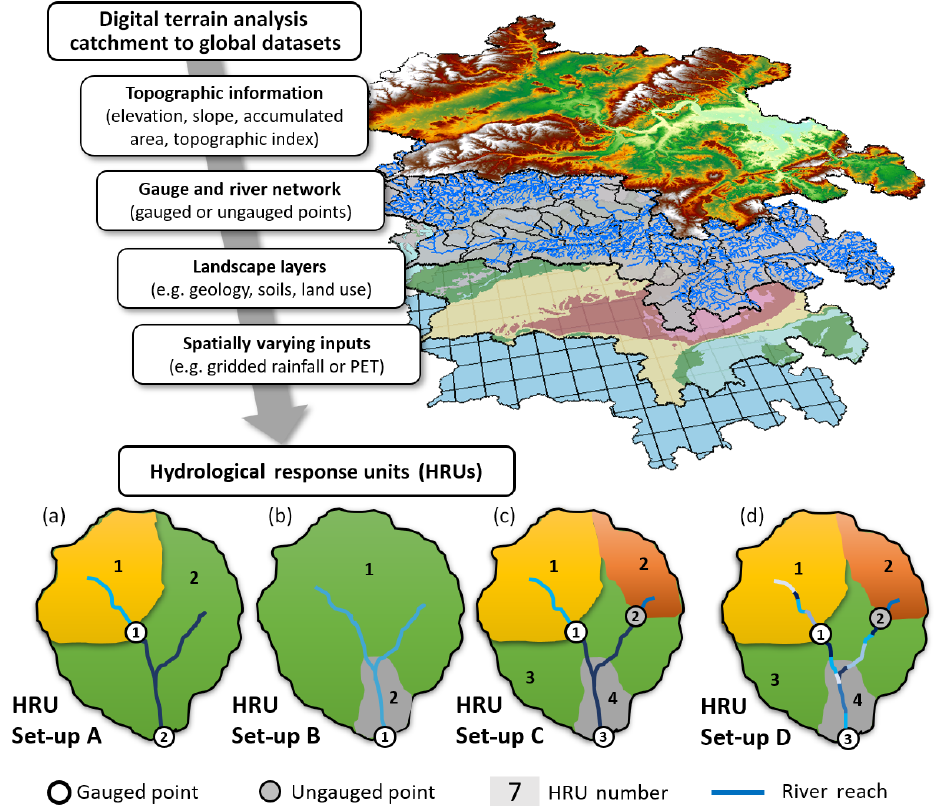
Figure 1. Digital terrain analysis and simplified examples of using classification layers to discretize a hypothetical catchment into hydrolog- ical response units, from (a) the gauge network; (b) landscape layer with a chalk outcrop for HRU 2; (c) the gauge network, ungauged flow point and landscape layer; and (d) same as (c) , with individual river reach lengths